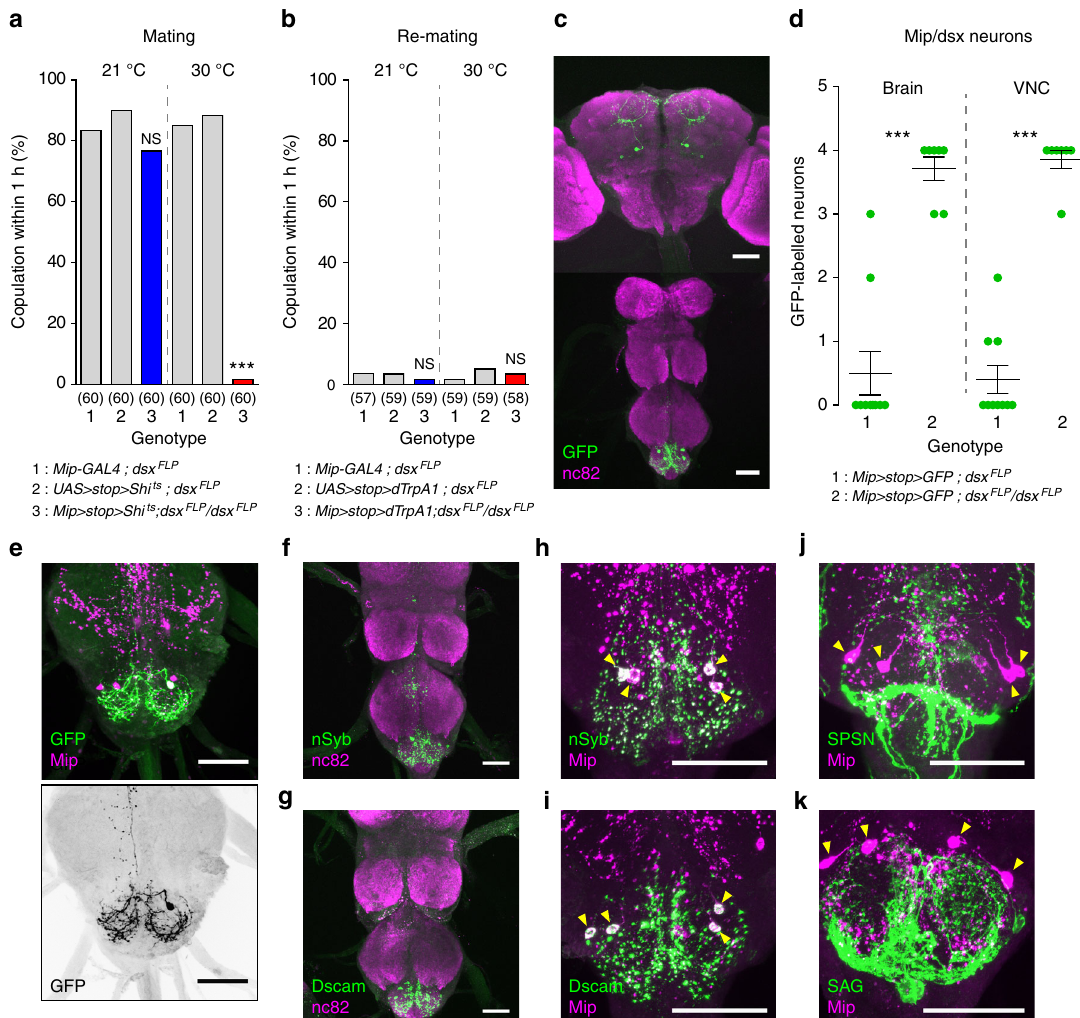
Fig. 4 Doublesex -positive abdominal Mip neurons are important for female receptivity. a Mating frequencies of virgin females of the indicated genotypes, scored as the percentage of females that copulate within 1 h. b Re-mating frequencies of the mated females. The numbers in parentheses indicate n . NS indicates non-signi fi cance ( P > 0.05); *** P < 0.001 for comparisons against both controls (grey bars); Chi-square test a , b . c Mip and dsx double-positive neurons in a female carrying Mip-GAL4, UAS > stop > mCD8-GFP and two copies of dsx FLP stained with anti-GFP (green) and anti-nc82 (magenta) antibodies. d The number of GFP-positive soma in the brain and VNC from females of the indicated genotypes. *** P < 0.001; unpaired t -test. Error bars indicate s.e.m. e Mip and dsx double-positive vAL neurons in the AG of a female carrying Mip-GAL4 , UAS > stop > mCD8-GFP and one copy of dsx FLP stained with anti-GFP (green) and anti-Mip (magenta) antibodies (upper panel). Note that only one of the four vAL neurons stained in the AG of this speci fi c preparation with the anti-Mip (magenta) antibody is GFP-positive (green). The lower panel is a negative image of the green channel from the upper panel image. Note that the single vAL cell extensively innervates the AG and projects one afferent axon along the midline to the thoracic ganglion. f vAL neurons from a female carrying Mip-GAL4 , UAS > stop > nSyb-GFP and dsx FLP stained with anti-GFP (green) and anti-nc82 (magenta). Note the localization of the presynaptic marker nSyb-GFP along the midline of the TG as well as in the AG. g vAL neurons from a female carrying Mip-GAL4 , UAS > stop > Dscam-GFP and dsx FLP stained with anti-GFP (green) and anti-nc82 (magenta). h A high magni fi cation view of the AG from a female carrying Mip-GAL4 , UAS > stop > nSyb-GFP and dsx FLP stained with anti-GFP (green) and anti-Mip (magenta). Arrowheads indicate vAL somas h – k . i The AG from a female carrying Mip- GAL4 , UAS > stop > Dscam-GFP and dsx FLP stained with anti-GFP (green) and anti-Mip (magenta). j The AG from a female carrying SPSN-GAL4 and UAS- mCD8-EGFP stained with anti-GFP (green) and anti-Mip (magenta). k The AG from a female carrying SAG-GAL4 and UAS-mCD8-EGFP stained with anti- GFP (green) and anti-Mip (magenta). All scale bars, 50 μ